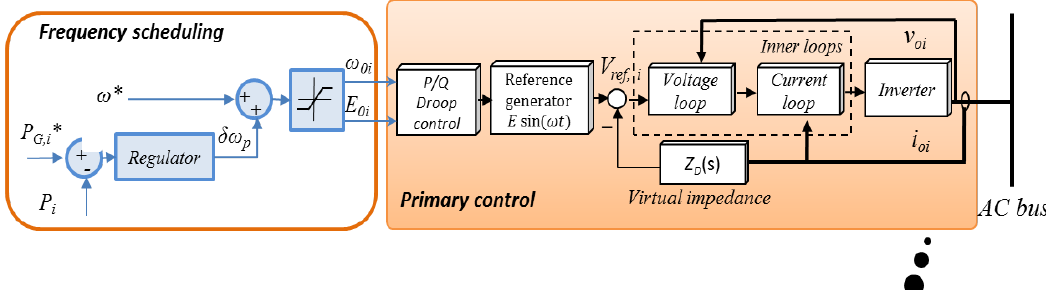
Figure 2. Lock diagram of frequency scheduling of each distributed generator (DG) unit.